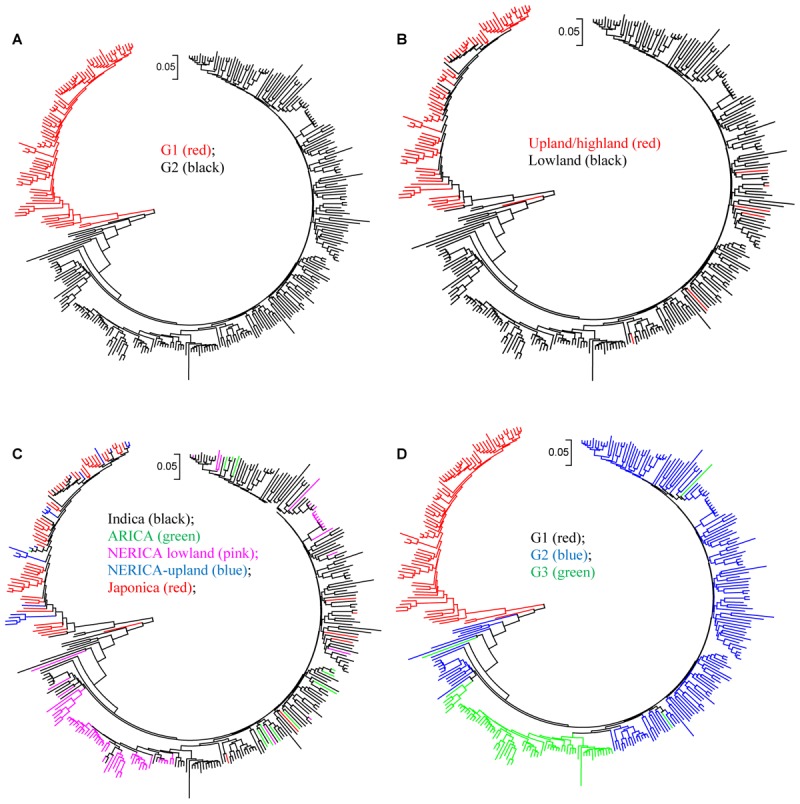
Neighbor joining tree for 330 rice genotypes based on identity-by-state genetic distance matrix computed from 15,020 SNPs: (A) groups based on cluster analysis; (B) groups based on ecology; (C) groups based on subspecies; and (D) groups based on STRUCTURE at K = 3. See Supplementary Table S1 and Supplementary Figure S2 for details.